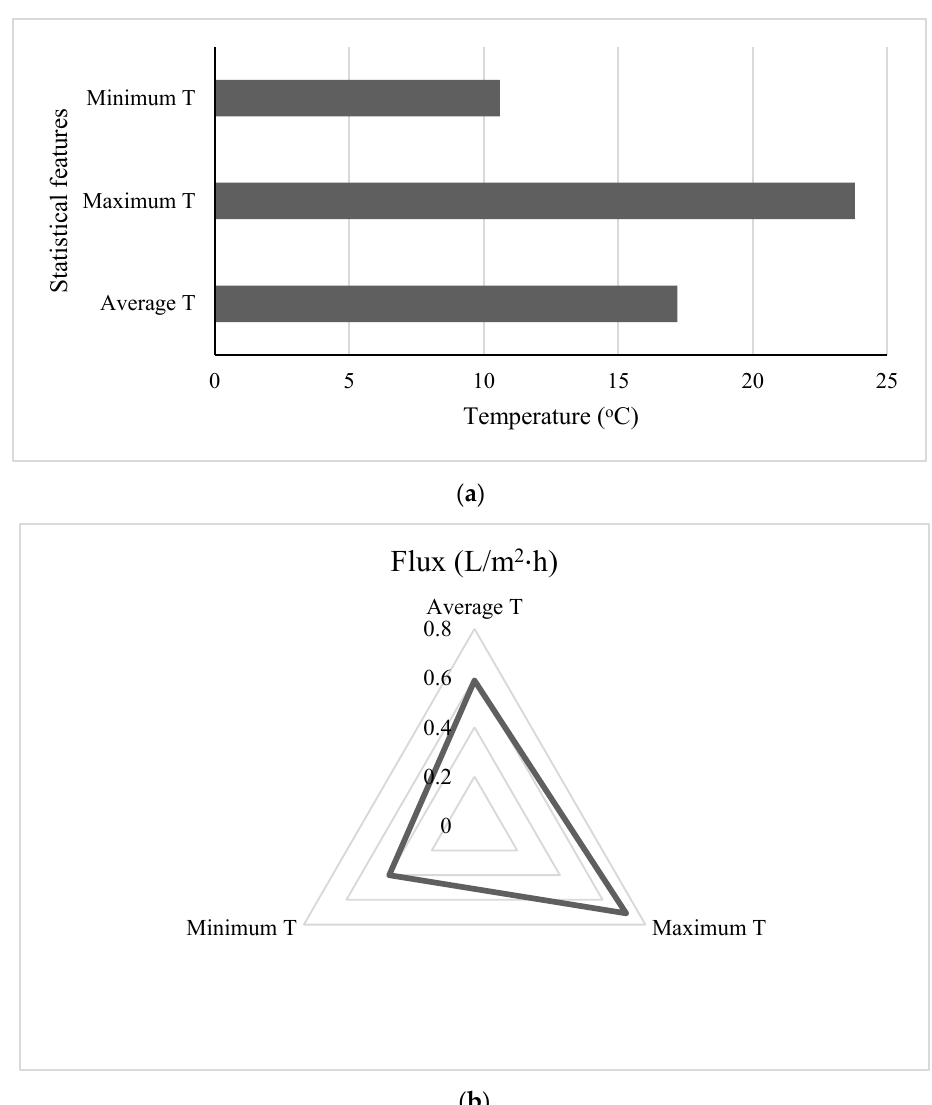
Figure 12. Effect of ( a ) the atmospheric temperature on the ( b ) water production rate.